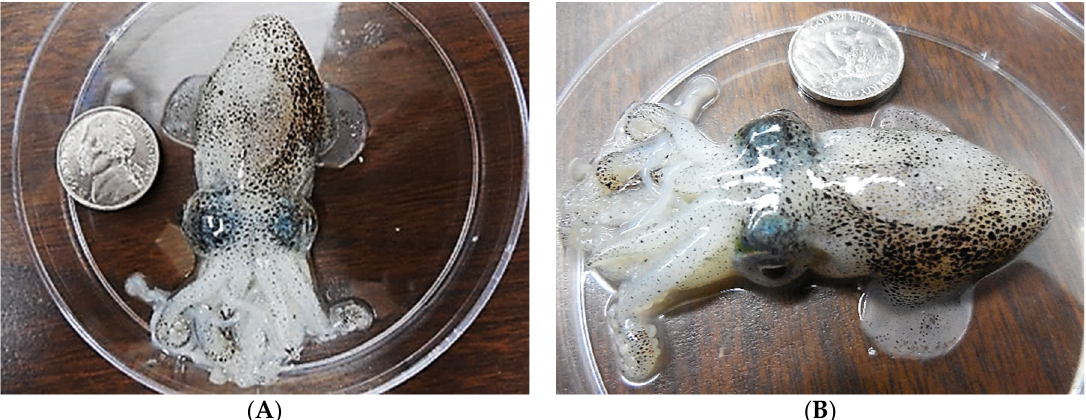
Figure 1. ( A , B ) show an adult six-month old Euprymna female squid from a top and side view, respectively. In captivity, adults can live up to about ten months. Females become reproductively active within 3 months of hatching. An American 5-cent coin (5¢, a nickel, diameter = 21.2 mm) provides scale. Pictures were taken with a HD Nikon L610 digital camera.